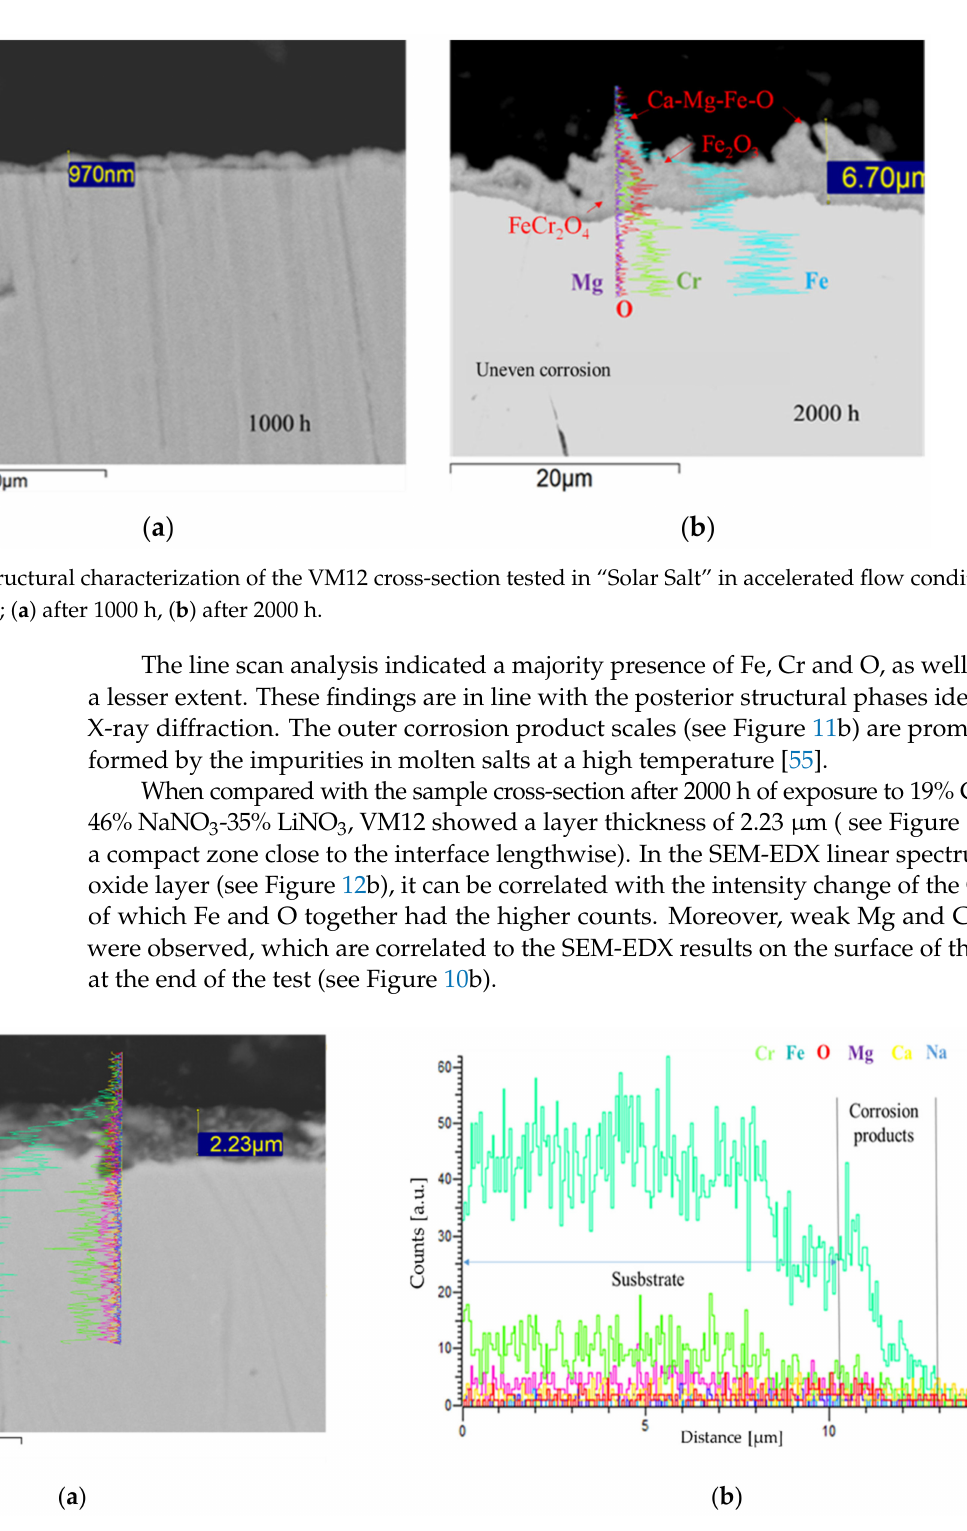
Figure 12. ( a ) Microstructural characterization of the VM12 cross-section tested in the ternary mixture 19% Ca(NO 3 ) 2 -46% NaNO 3 -35% LiNO 3 in accelerated flow conditions (0.2 m/s) at 500 ◦ C after 2000 h ( b ). Graph of the linear spectrum of the oxide